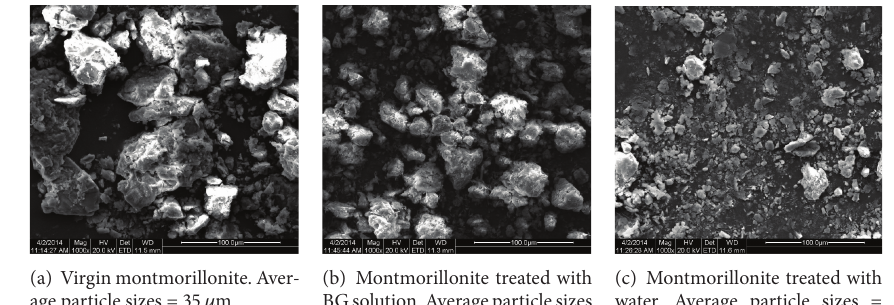
Figure 9: SEM of montmorillonite treated with different ways.